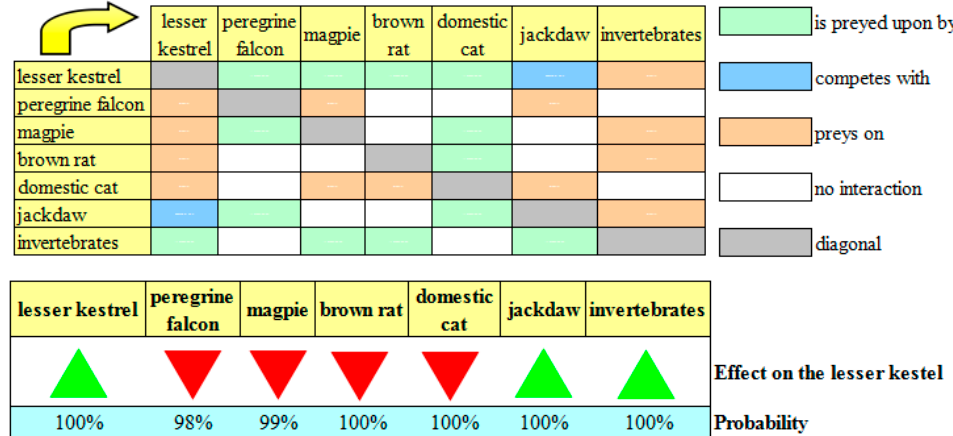
Figure 3. ( Top ) The current community matrix of the lesser kestrel in the Alta Murgia. The matrix must be read from the rows to the columns. ( Bottom ) Table of predictions. Key to reading: an increase in the growth rate of the peregrine falcon (for example, due to an increase in fecundity or a decrease in mortality) will result in a decrease in the lesser kestrel population stock, with probability equal to 98%. Predictions are shown for positive inputs. In the case of negative inputs (e.g., a decrease in the growth rate of the peregrine falcon), the predicted effects on the lesser kestrel population stock must be inverted, but the probabilities remain unchanged.